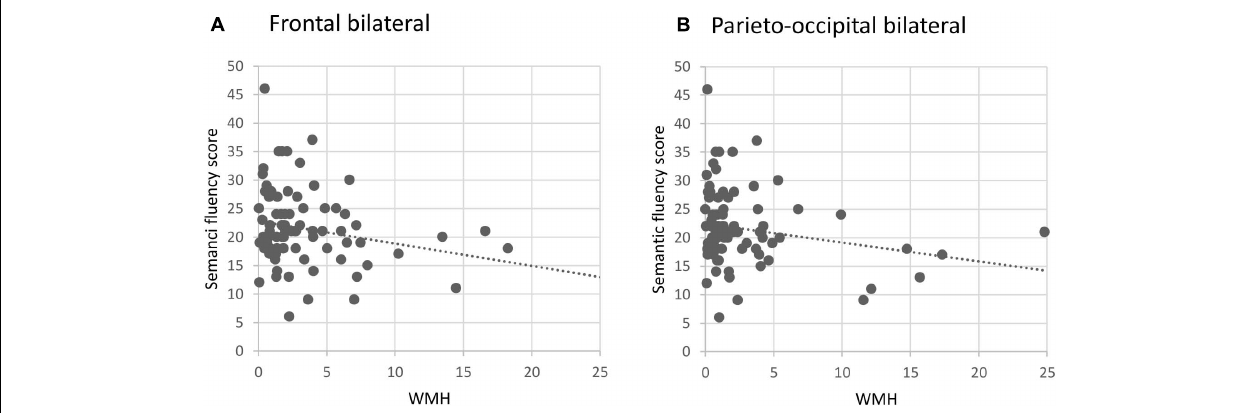
FIGURE 1 | Semantic fluency as a function of bilateral (A) frontal and (B) parieto-occipital white matter hyperintensities in right-handed participants ( n = 79). WMH, white matter hyperintensities